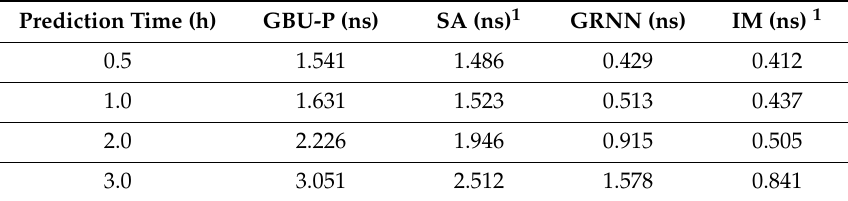
Table 3. Prediction errors at different prediction times.